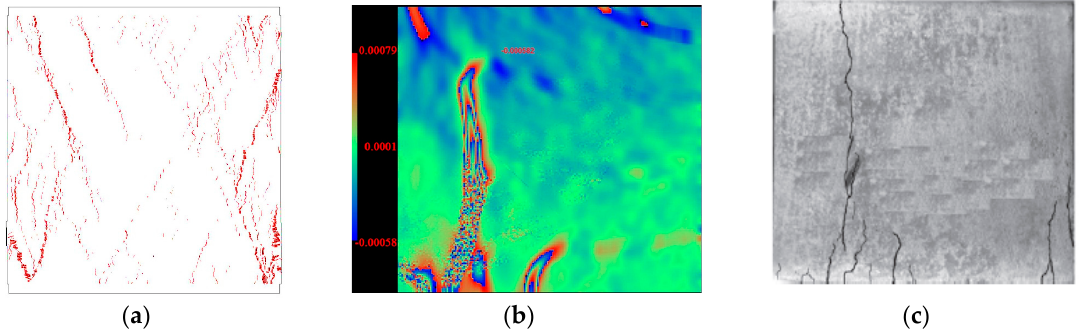
Figure 9. Microcracks distribution in CM at failure state ( a ) numerical results; ( b ) DIC measurement; ( c ) fracture pattern.